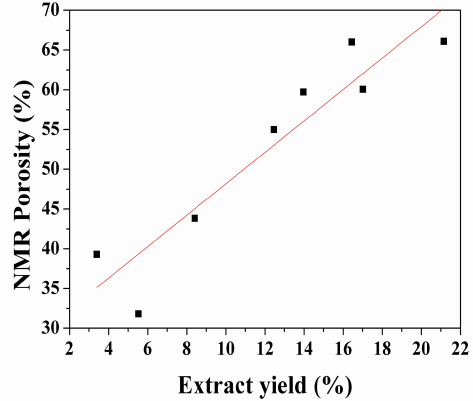
Figure 14. Correlation between yield and NMR porosity after sub-critical water